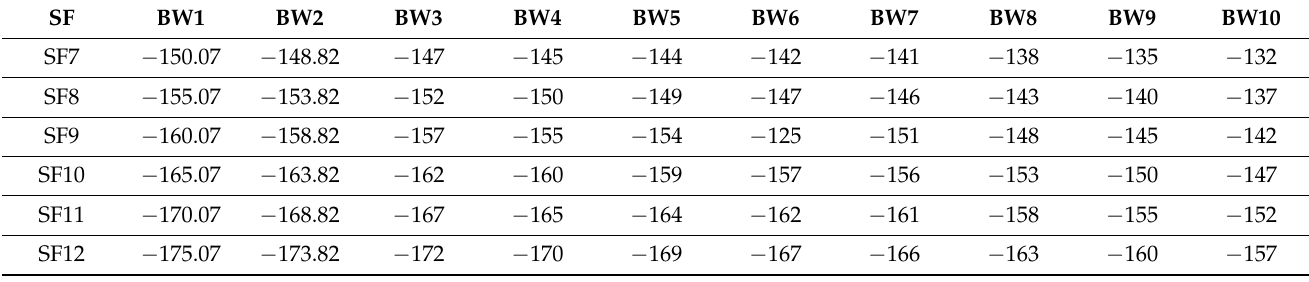
Table 9. Receiver sensitivity of LoRa.